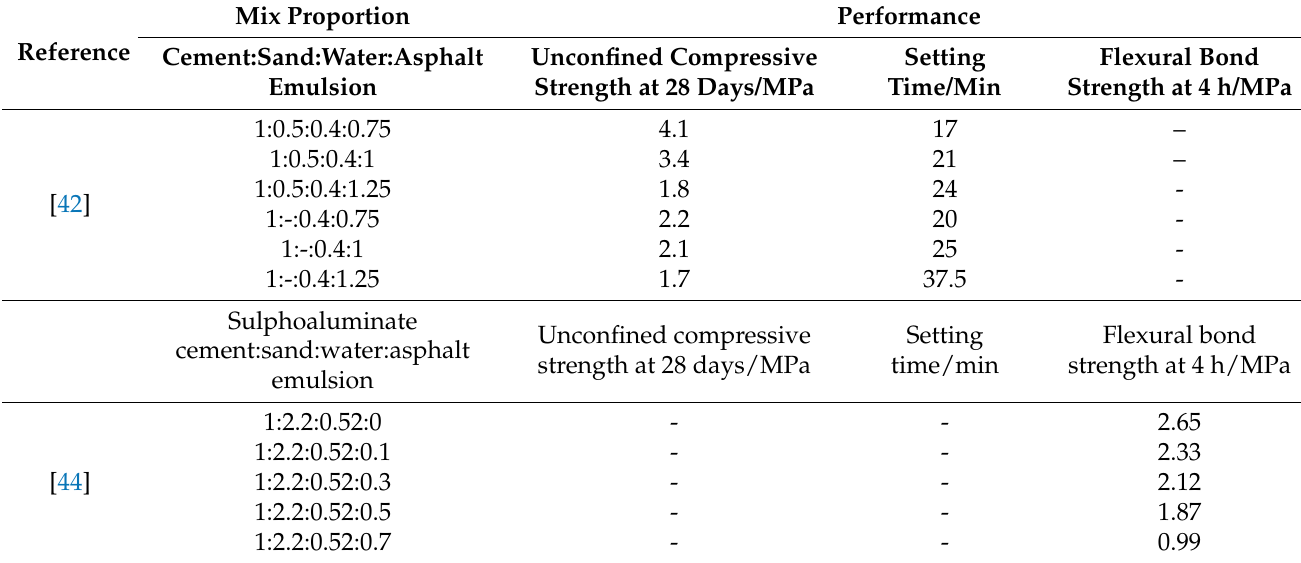
Table 9. Properties of cement asphalt mortar as repair material.